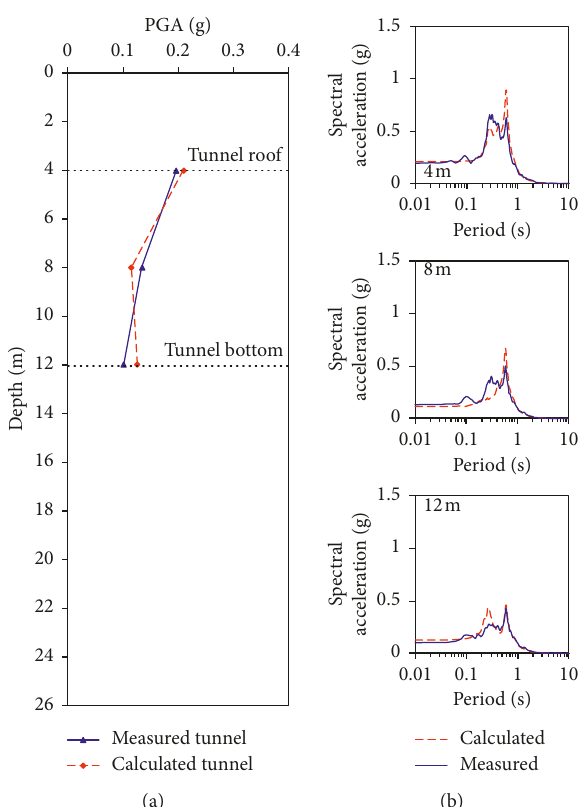
Figure 8: Comparison of the measured and calculated tunnel responses. (a) PGA profile. (b) Acceleration response spectra at top slab (4m), midwall (8m), and bottom floor (12m) of the